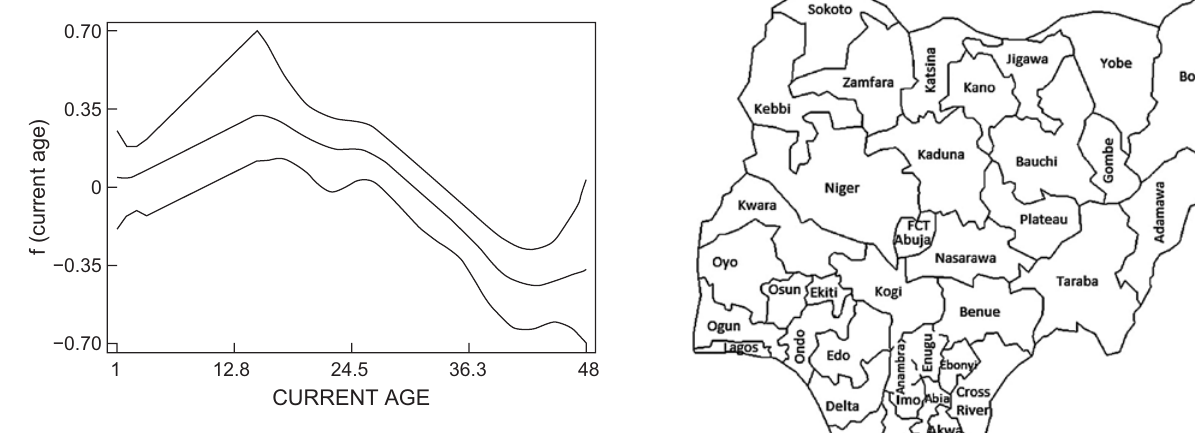
Figure 1: Nonlinear effect of current age on unmet need for FP at 95% CI.